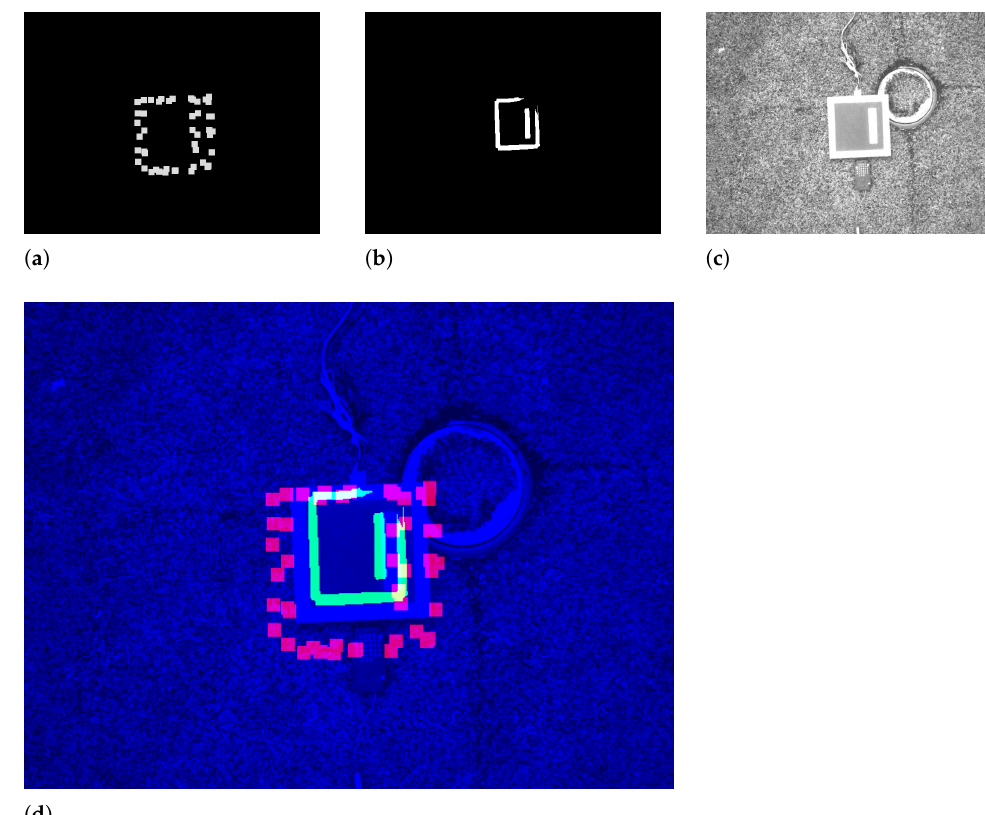
Figure 4. The individual channels and the aggregated RGB image. ( a ) The LiDAR channel. ( b ) The thermal channel. ( c ) The visual channel. ( d ) The aggregated